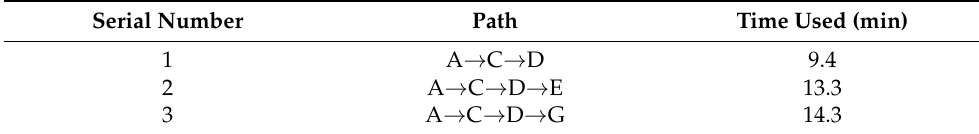
Table 2. Material-allocation path and time used.